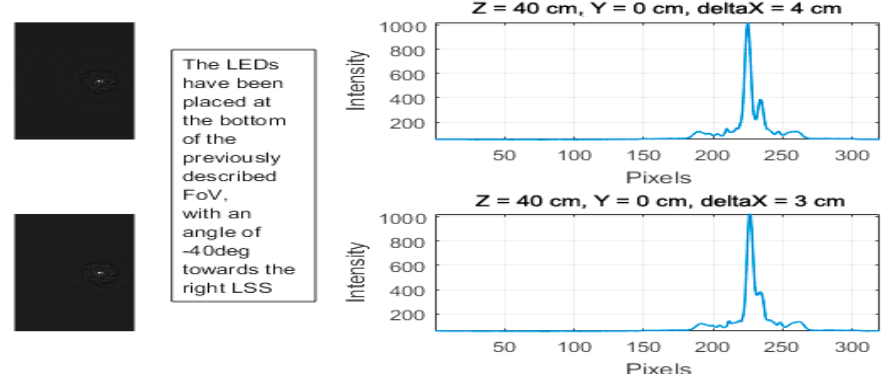
Figure 3. LEDs placed at FoV = 40° moved closer from 4 cm to 3 cm.